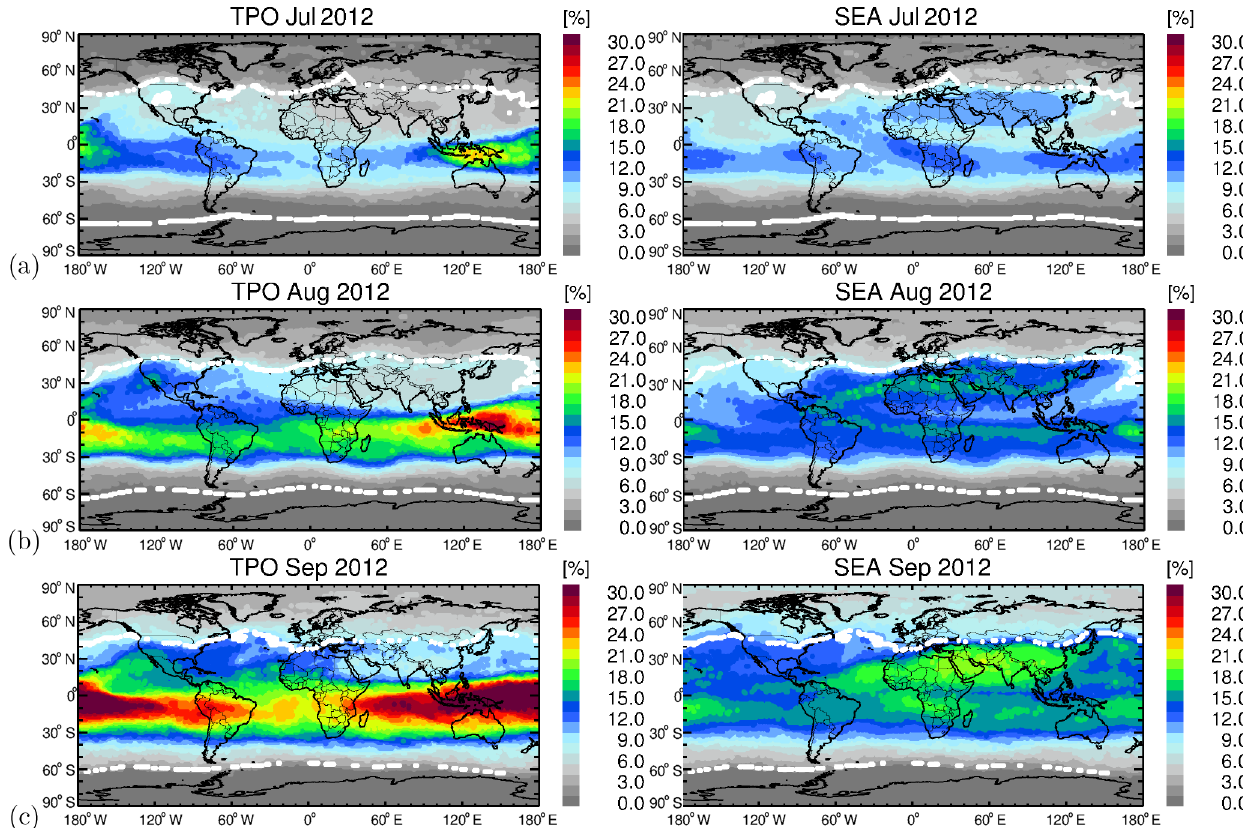
Figure A1. Mean values of the contribution of the emission tracer for the tropical Pacific Ocean (left) and southeast Asia (right) at 380K in July (a) , August (b) , and September (c) 2012. The climatological isentropic transport barriers of 7.2PVU (Northern Hemisphere) and − 11.5PVU (Southern Hemisphere) at 380K are shown as thick white